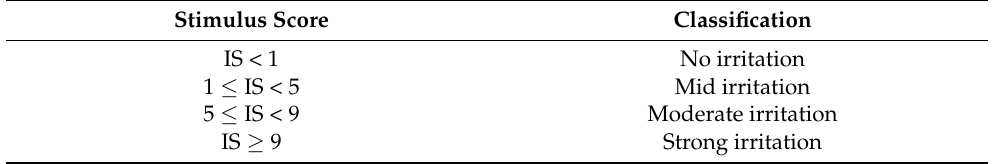
Table 2. Results of irritation evaluation score.